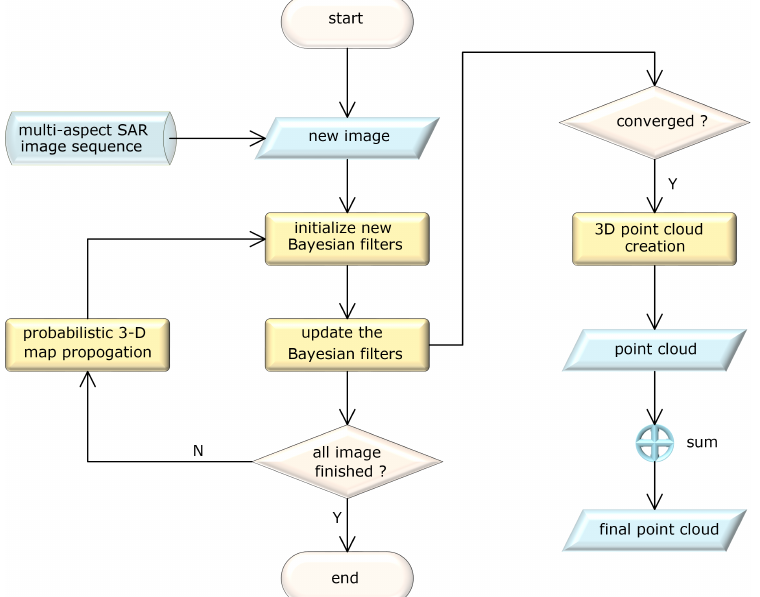
Figure 5. Flowchart for 3D point cloud generation; 3D map points are maintained and updated by Bayesian